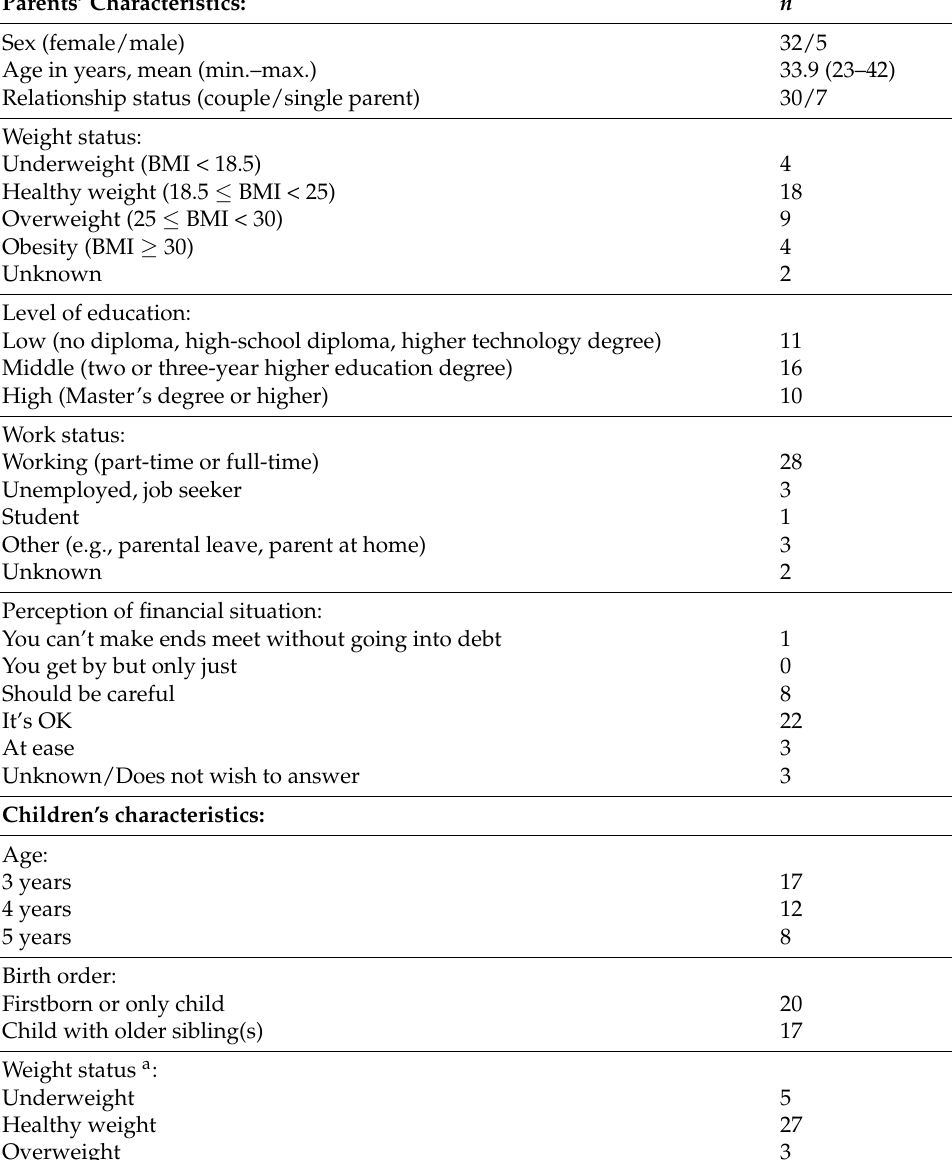
Table 1. Characteristics of participating parents ( n = 37) and their